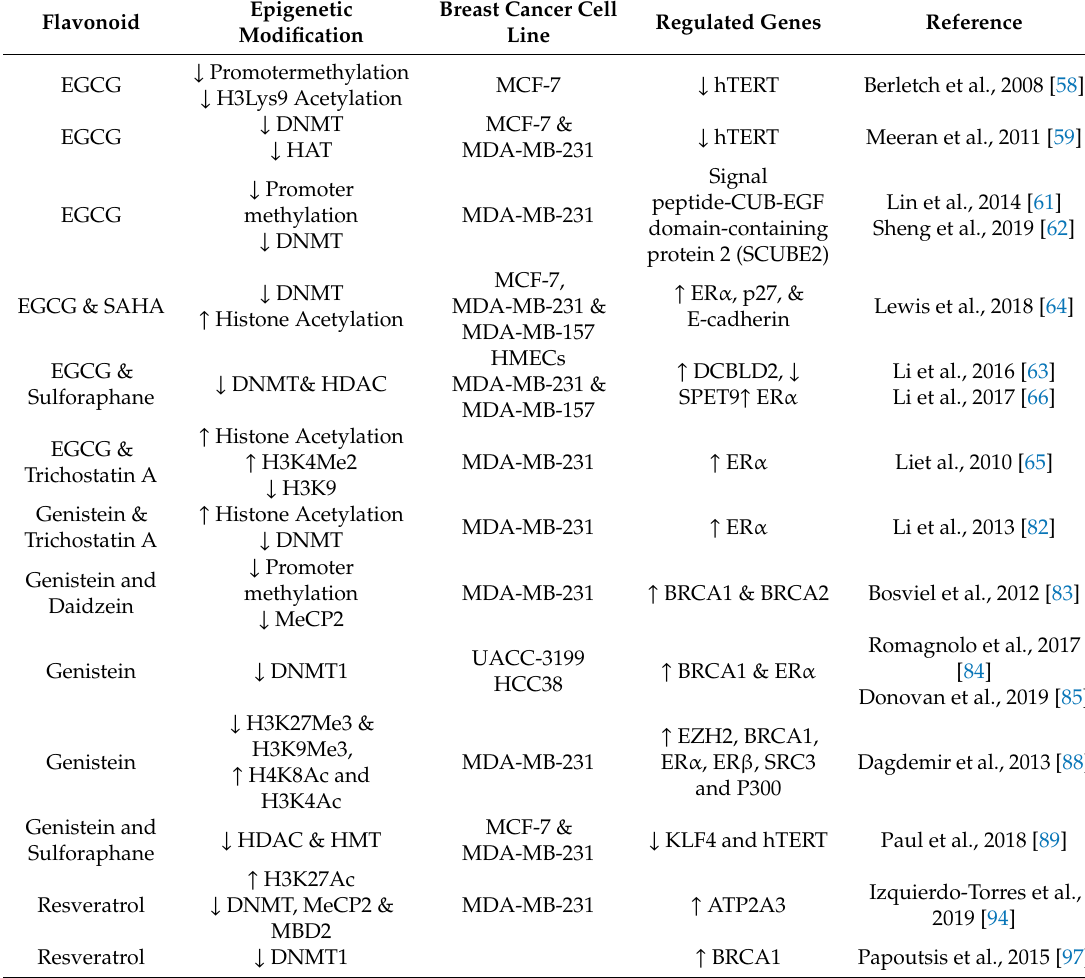
Table 4. Summary of epigenetic modification of di ff erent genes.